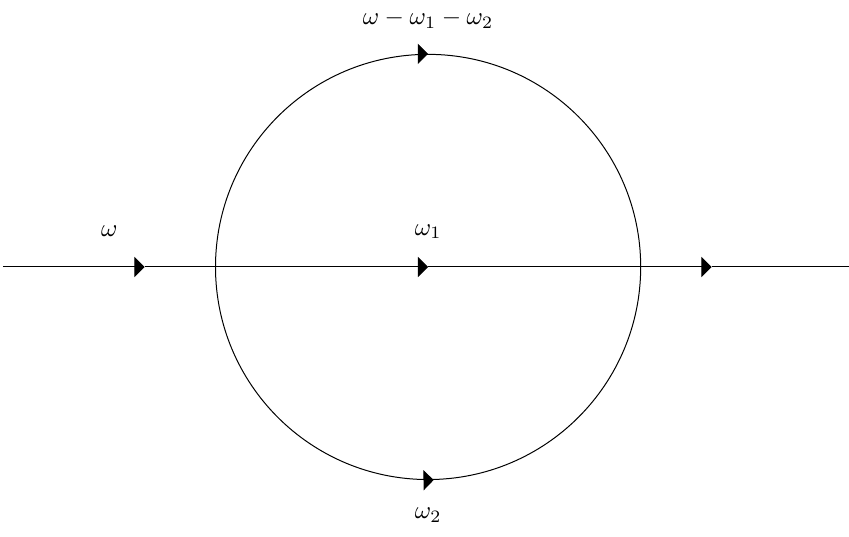
Figure 1 . Two loop contributions to the fermion two point